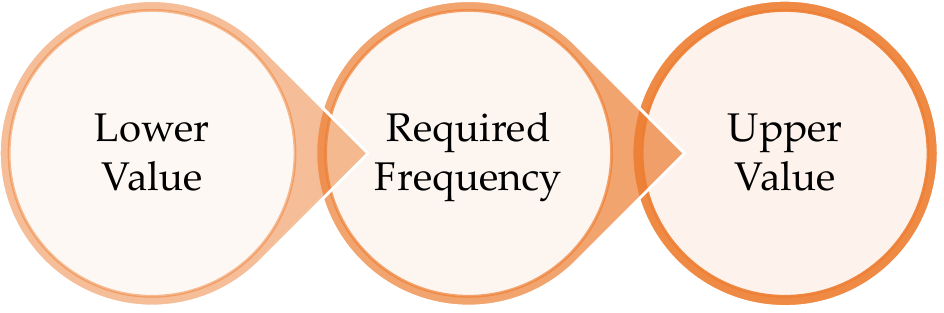
Figure 2. Frequencies ranges of Twitter